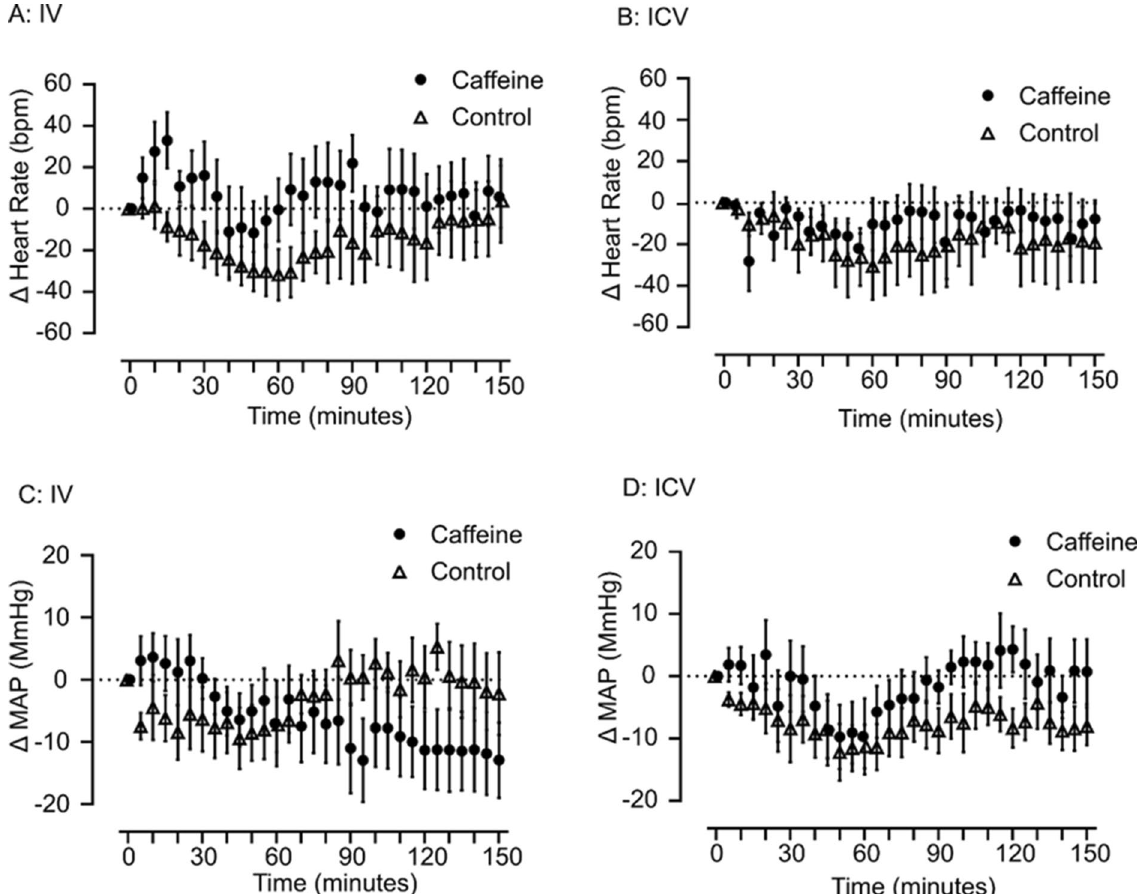
Figure 2. Changes in heart rate and mean arterial pressure in rats following an administration of caffeine. Changes in beats per minute of heart rate from baseline to 150 min post treatment of caffeine or vehicle ( A ) IV †; ( B ) ICV †. Changes in mean arterial pressure from baseline to 150 min post treatment ( C ) IV †; ( D ) ICV †. Filled circle = Caffeine, open triangle = Control. Error bars represent S.E.M., n = 8 per intervention, † raw data shown in figure, but data were transformed prior to analysis (see “Materials and methods”